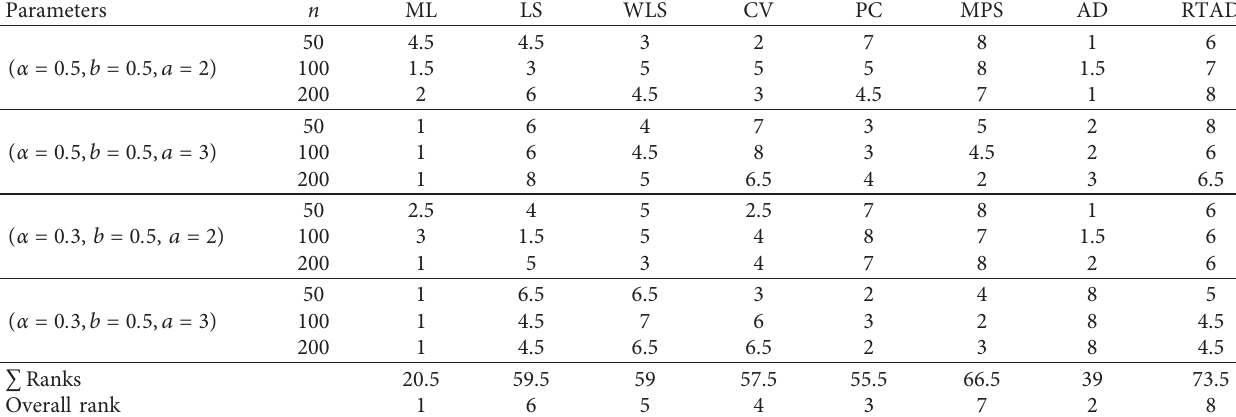
Table 5: Partial and overall ranks of all the methods of estimation for various combination of parameters.